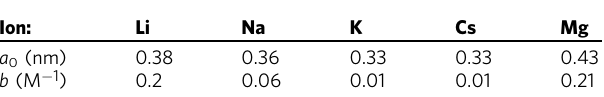
Table 1 Parameters used for the calculation of electrolyte